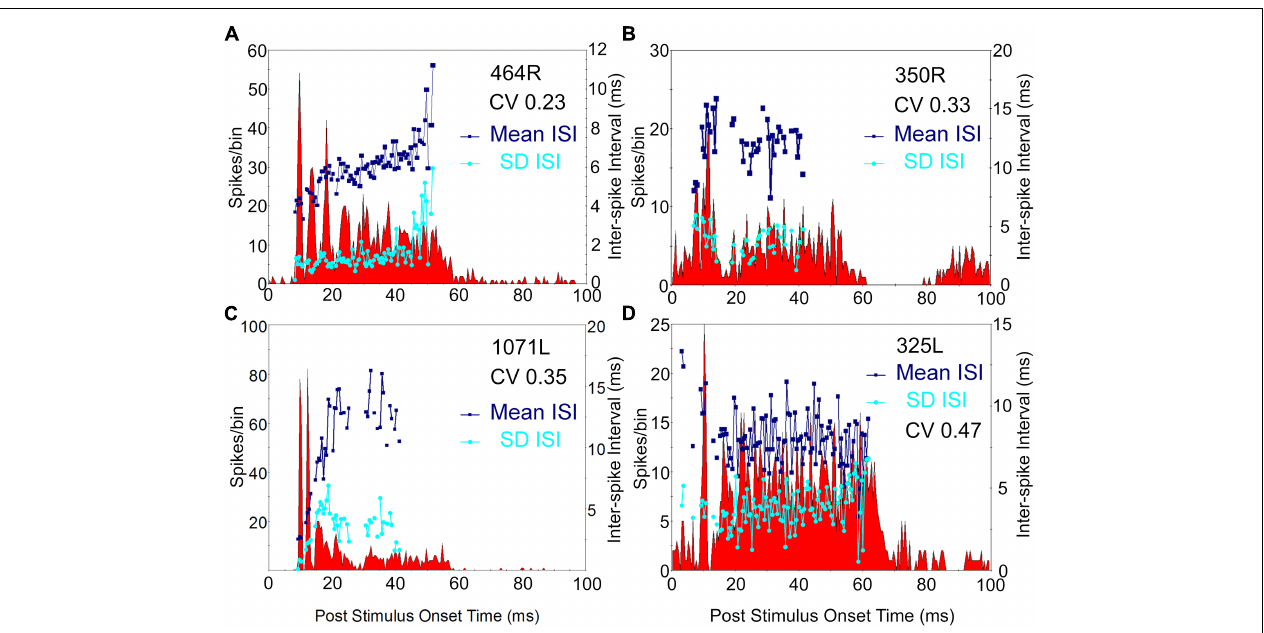
FIGURE 5 | Peri stimulus time histograms (PSTHs) of four cells showing chopper responses. Three of these cells (A–C) have basket-like endings and the fourth (D) had an axon that was not stained. The histograms show the probability of firing at a set time after the onset of a 50 ms tone presented at 20 dB above threshold at CF, to the contralateral ear. Binwidth is 0.5 ms. A regularity analysis is superimposed on each histogram with the navy blue squares showing the mean interspike intervals (ISI) for the spikes following those in each bin lying between 7 and 47 ms after stimulus onset. The SD of each mean value for a bin is plotted as a cyan dot. These values allow the coefficient of variation (CV) to be calculated and these are indicated in the top right of each panel. For the first three chopping units there are at least two peaks in the firing at the start of the response and these are separated by 3–8